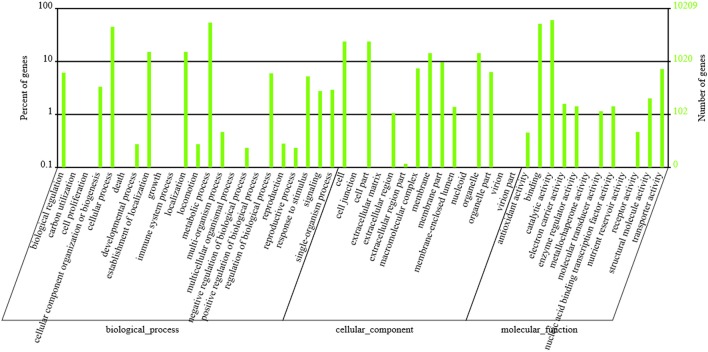
GO classification of P. liquidambari unigenes. Left vertical coordinate indicates the percentage of a specific category of unigenes in the main category, right vertical coordinate indicates the number of unigenes in a category.